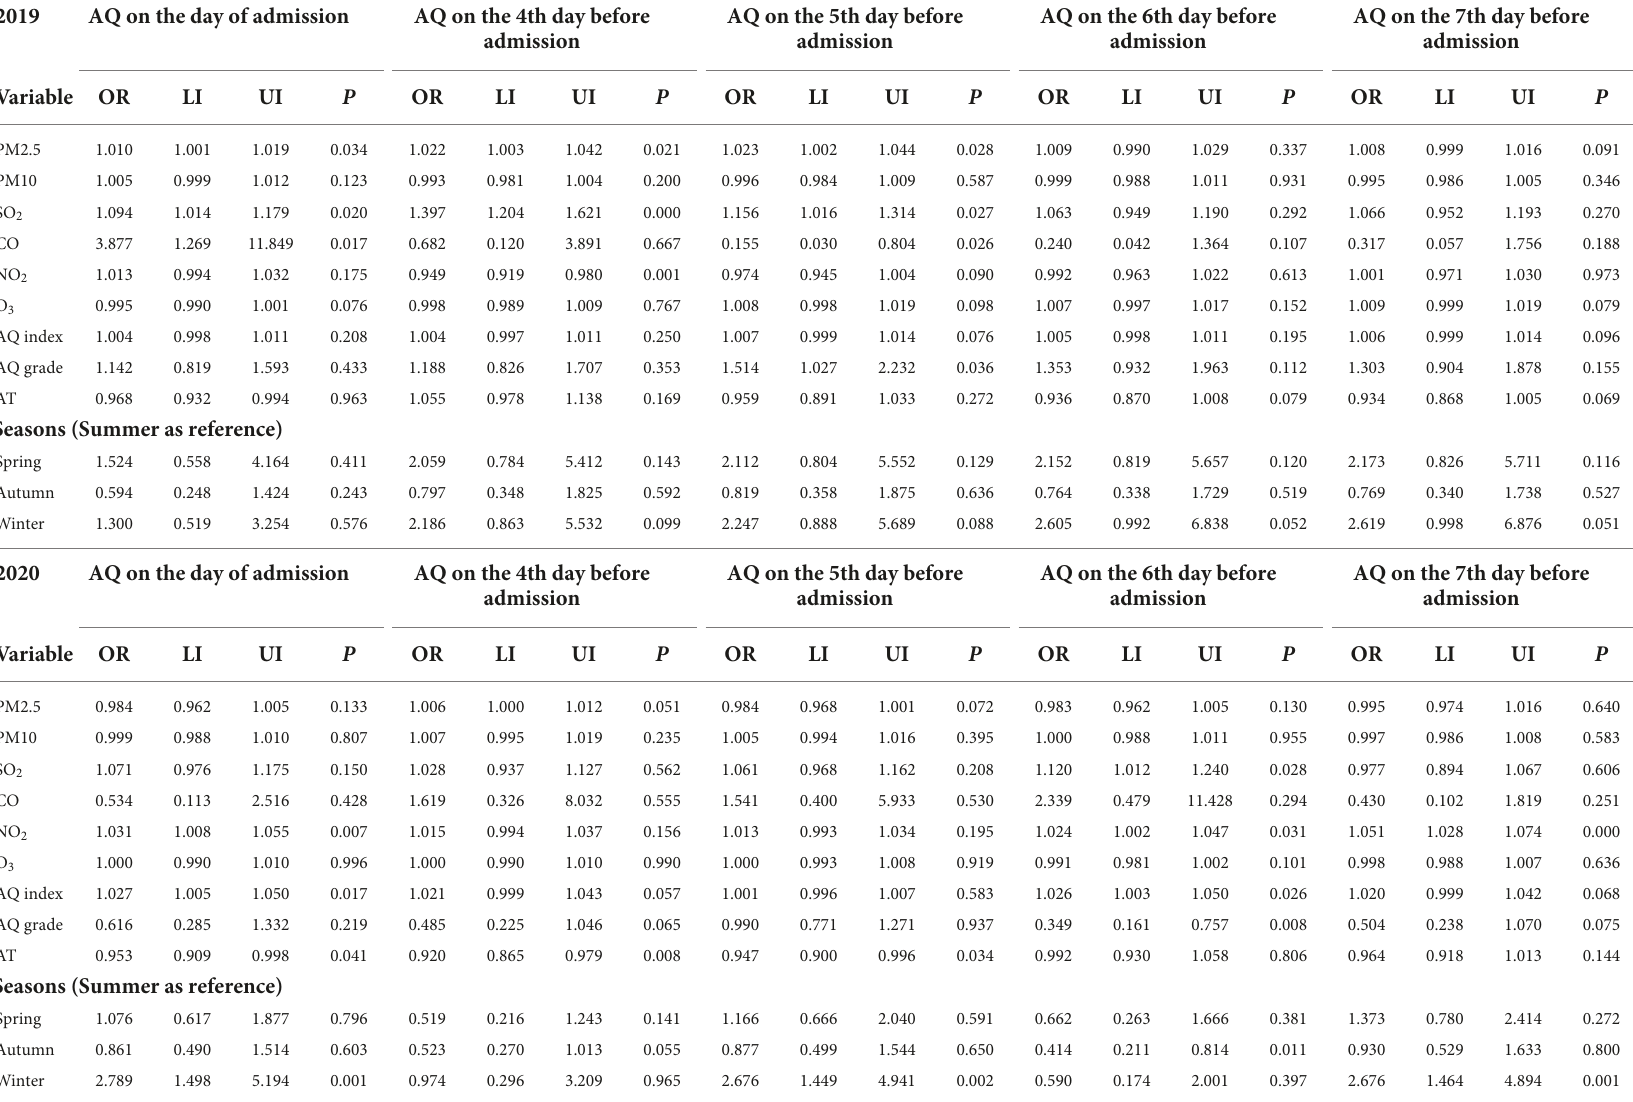
TABLE 2 Multiple factor binary logistic regression investigating independent predictors of admission due to